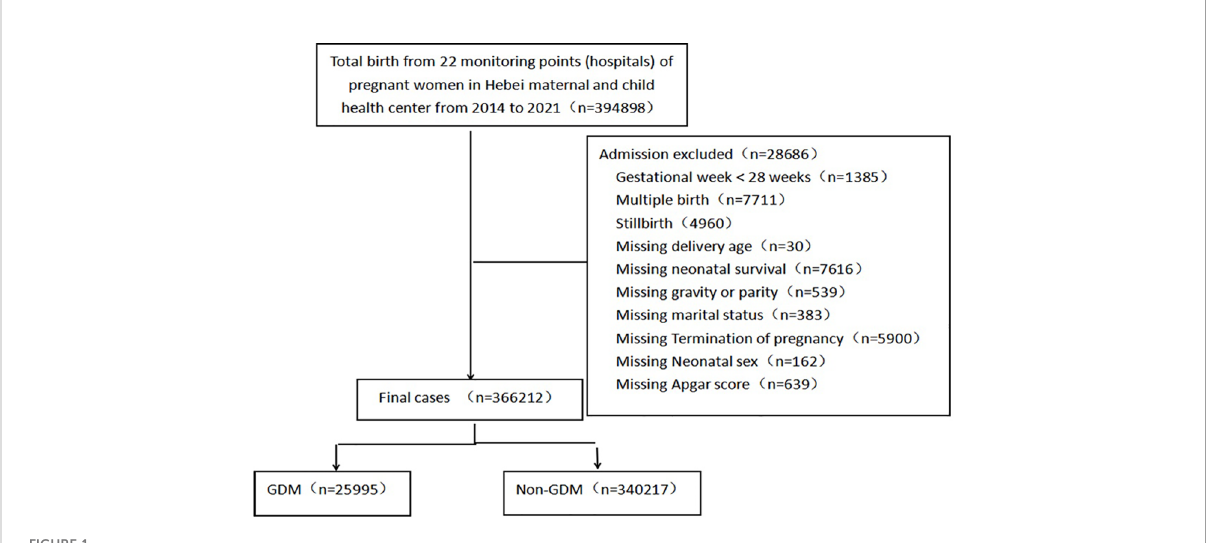
FIGURE 1 The fl ow chart of cases